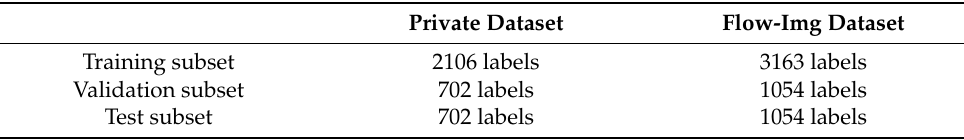
Table 1. Splitting of datasets into training, validation, and test subsets.